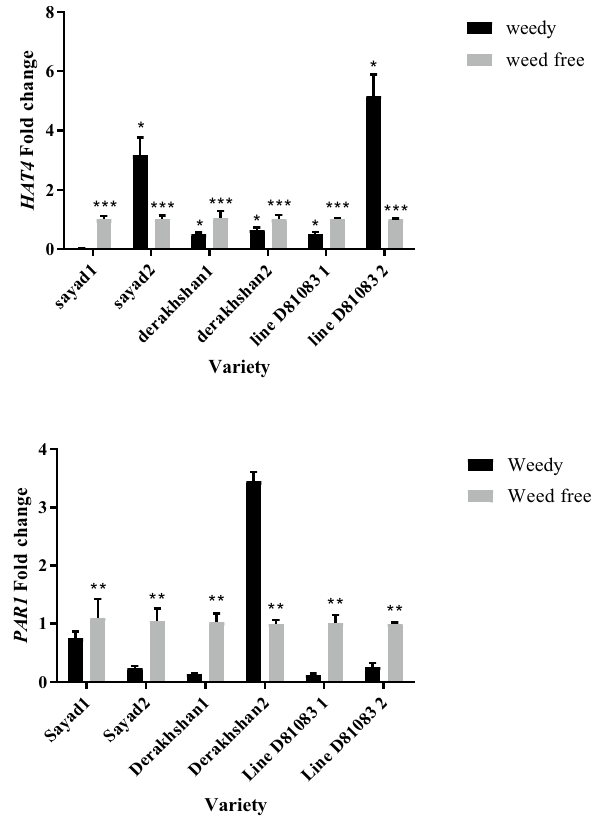
Figure 7. Real-time PCR (qRT-PCR) analysis of HAT4 and PAR1 genes transcript levels in two treatments weedy and weed free, in the three cultivars/lines studied and in two stages of sampling V4 and R7 (data are the mean ± standard error in five biological replications and five technical replications, numbers 1 and 2 next to the name of the cultivar represent the V4 and R7 stages, respectively). ***: P < 0.99; **: P < 0.95; *: P <